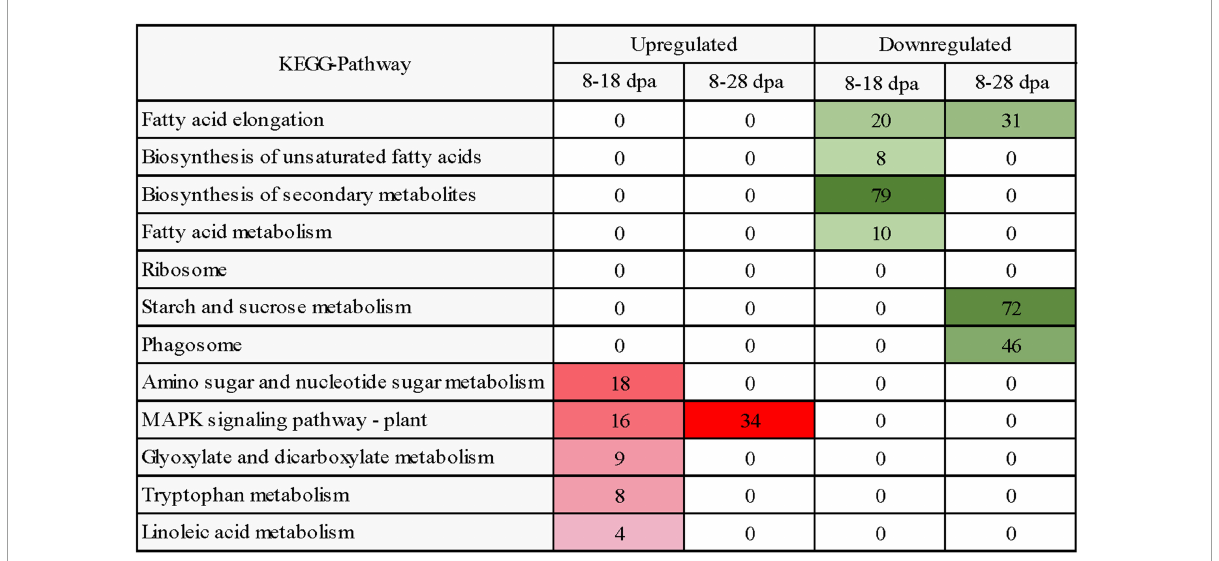
FIGURE7 Heatmap diagram reflecting the dynamics of enriched biological process in KEGG analysis during seed development. Enriched processes with FDR < 0.05 were included in the heatmap. Red and green colors represent upregulated and downregulated DEGs, respectively. The intensity of the color reflects the number of DEGs as indicated at each development